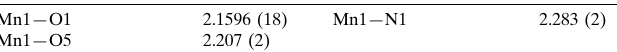
Selected bond lengths (A˚ ).